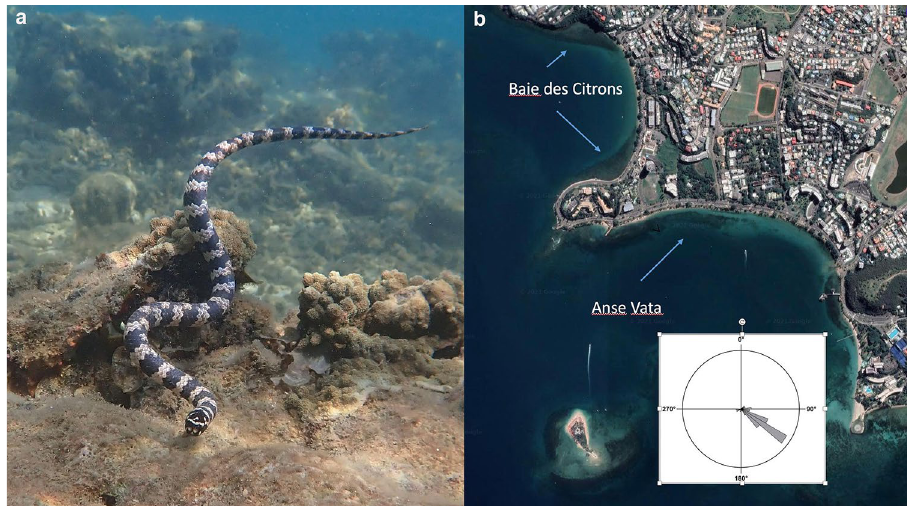
Figure 1. Turtle-headed sea snake Emydocephalus annulatus ( a ) and the location of the three study sites used ( b ). On the aerial photograph, areas of coral reef habitat are darker than adjacent sandy sites; the arrows point to reef areas at Anse Vata, and on the northern and southern ends of the Baie des Citrons. The inset diagram shows the compass direction from which winds blow, based on monthly mean data, showing that Anse Vata is more exposed than the Baie des Citrons. Photograph ( a ) by Claire Goiran. Photograph ( b ) modified from https:// earth. google. com/ web/@- 22. 29399 082,166. 44822 979,20. 67054 793a,11283. 26626